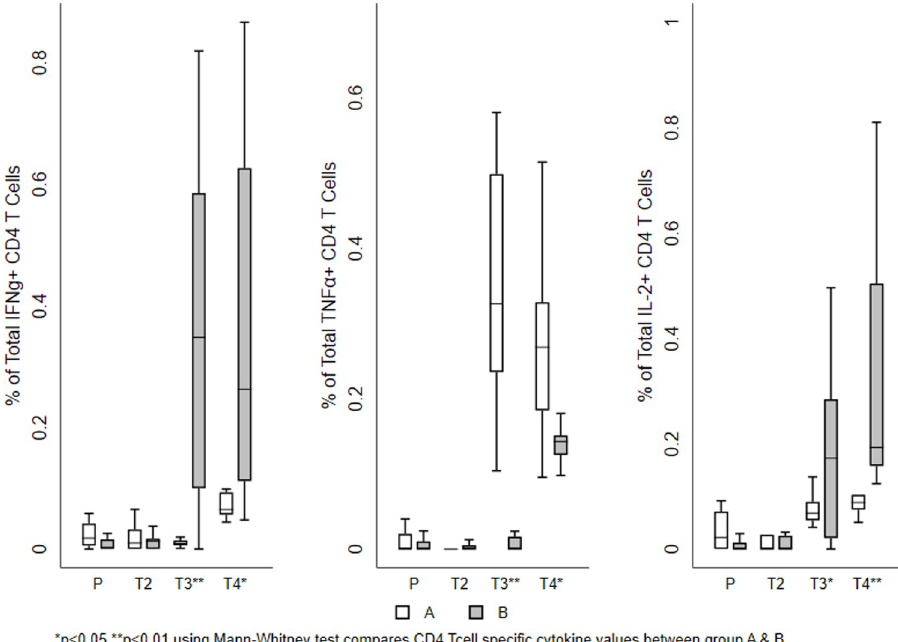
Fig 3. Vaccine-induced HIV-1-specific CD4 + T cell responses. Frequency of vaccine-specific CD4+ T cells measured at different time points. The mean value of the total responses (Env, Gag, and Pol) obtained for each T cell sub population is shown. (A) Frequency of IFN- γ positive vaccine induced T cell subsets. (B) Frequency of TNF- α producing vaccine induced T cell subsets. (C) Frequencies of IL-2 producing vaccine induced T cells sub populations. The box plots show the distribution of responses in positive responders only. The boxes indicate the median (solid line), mean (dashed line), and interquartile range (IQR). P values for significant differences were determined using the Mann-Whitney T test and are represented using the symbol � (Note: P-Placebo, T2-Prevaccination, T3-Second week after first MVA vaccination, T4-Second week after last MVA vaccination).